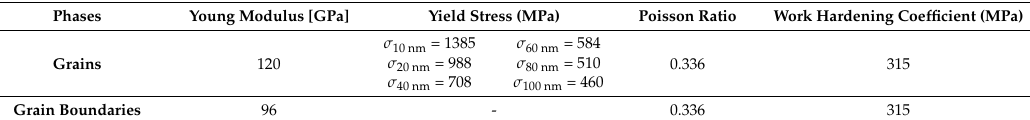
Figure 9. Meshed Voronoi unit cell. Table 1. Material properties used in the Table 1. Material properties used in the simulations.